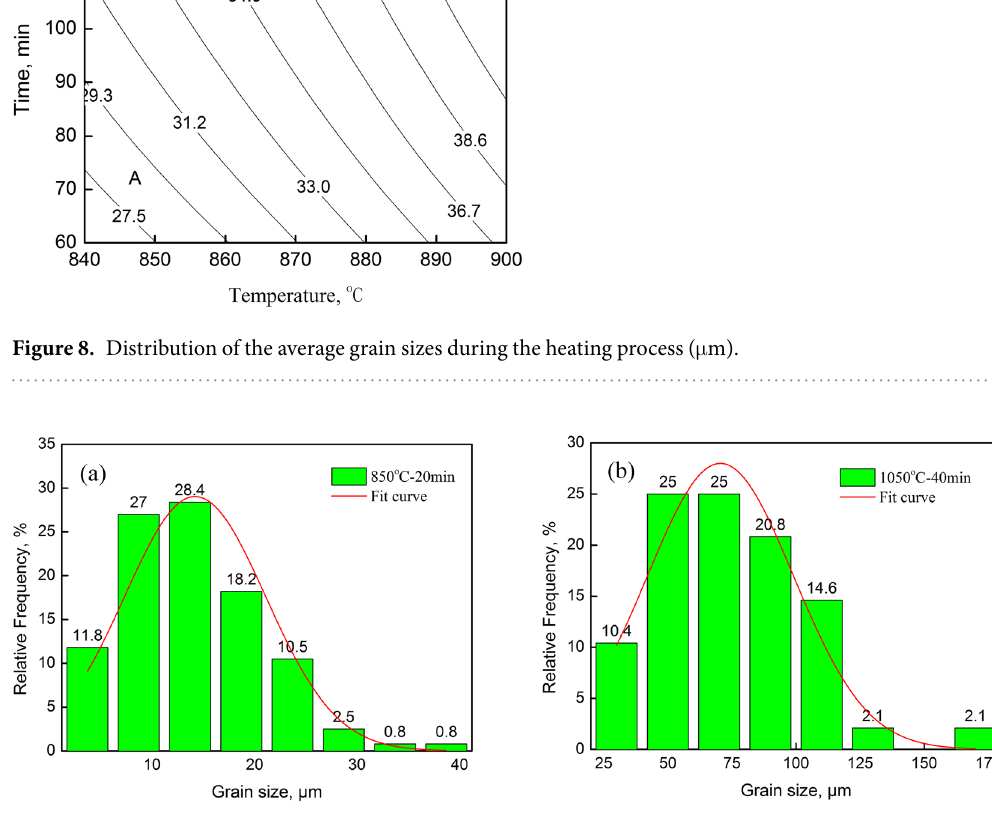
Figure 9. The effects of the heating conditions on the average grain size ( d s ). ( a ) 850 °C-20 min; ( b ) 1050 °C-40